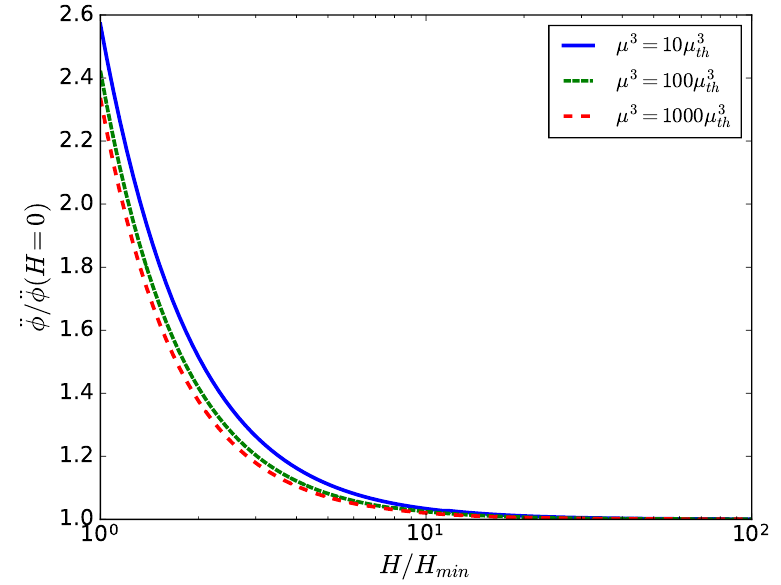
Figure 9 . The ratio between (cid:127) (cid:30) by eq. (3.33) and (cid:127) (cid:30) by eq. (3.24) with _ (cid:30) = (cid:22) 3 = 3 H . H min and (cid:22) 3 are de(cid:12)ned in eq. (3.32). This (cid:12)gure is independent on the choice of f .